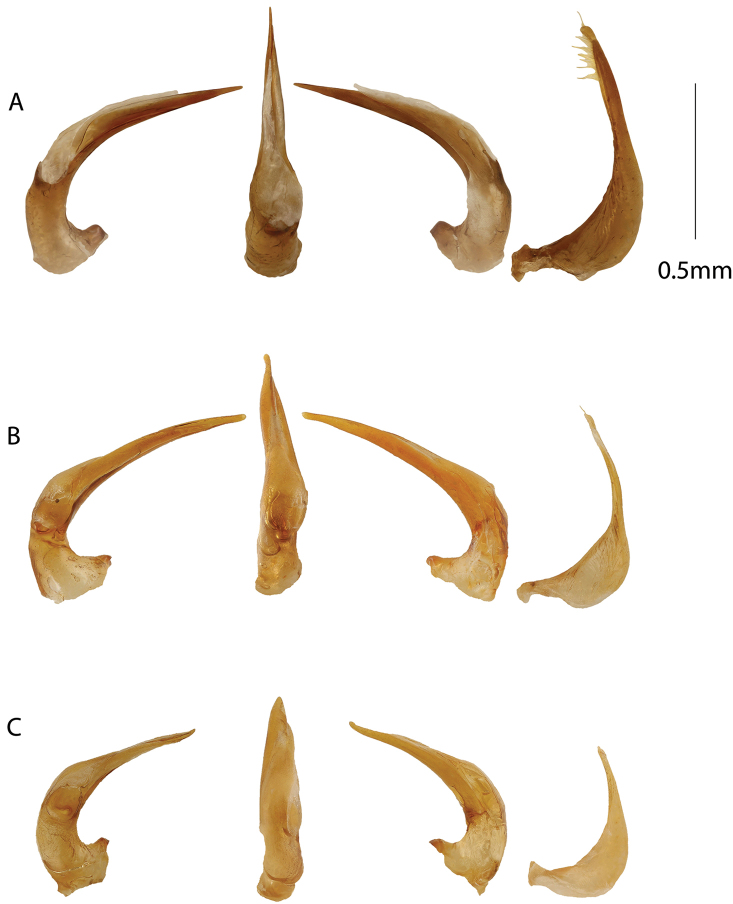
Male genitalia. From left to right aedeagus in right lateral, ventral, left lateral views, and left paramere. AMadaglymbus
semifactus sp. nov. BMadaglymbus
kelimaso sp. nov. CMadaglymbus
menalamba sp. nov.